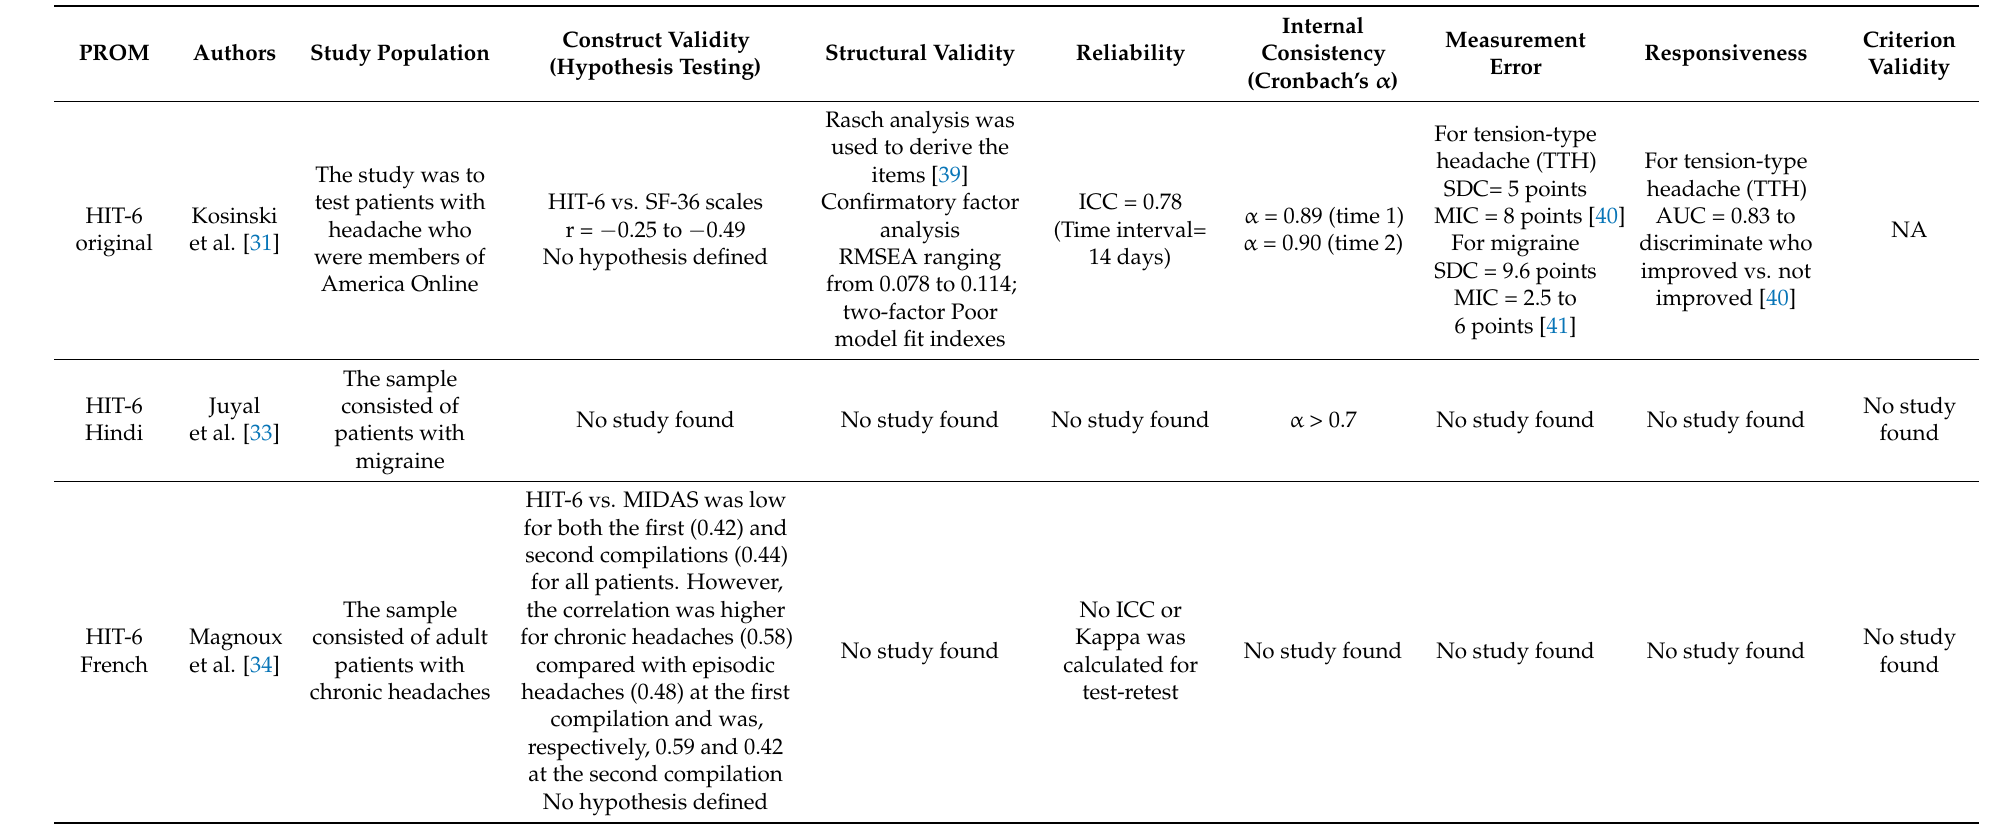
Table 6. Summary of the measurement properties of each Headache Impact Test-6-item (HIT-6)